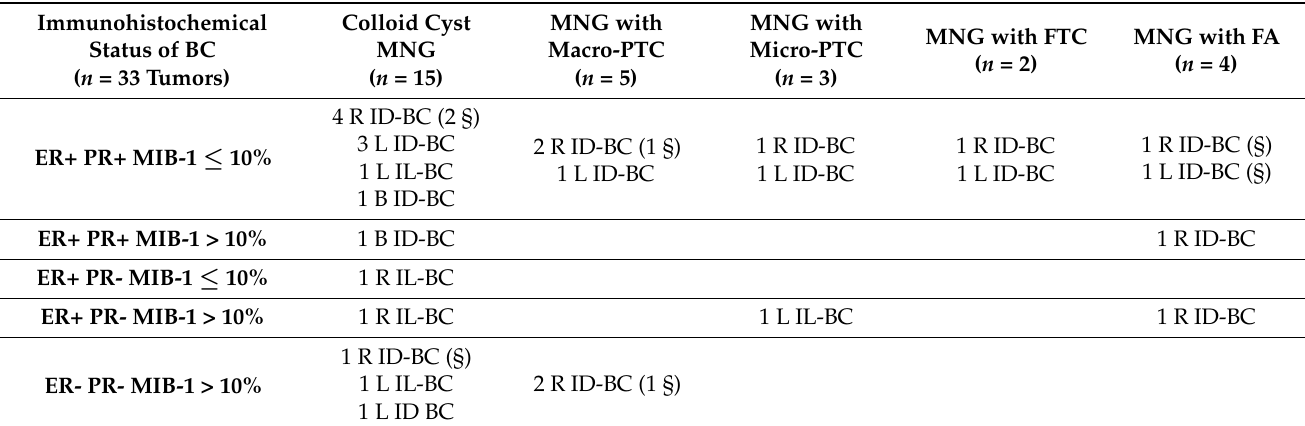
Table 3. Relationships between immunohistochemical status of patients operated for BC and associ- ated thyroid